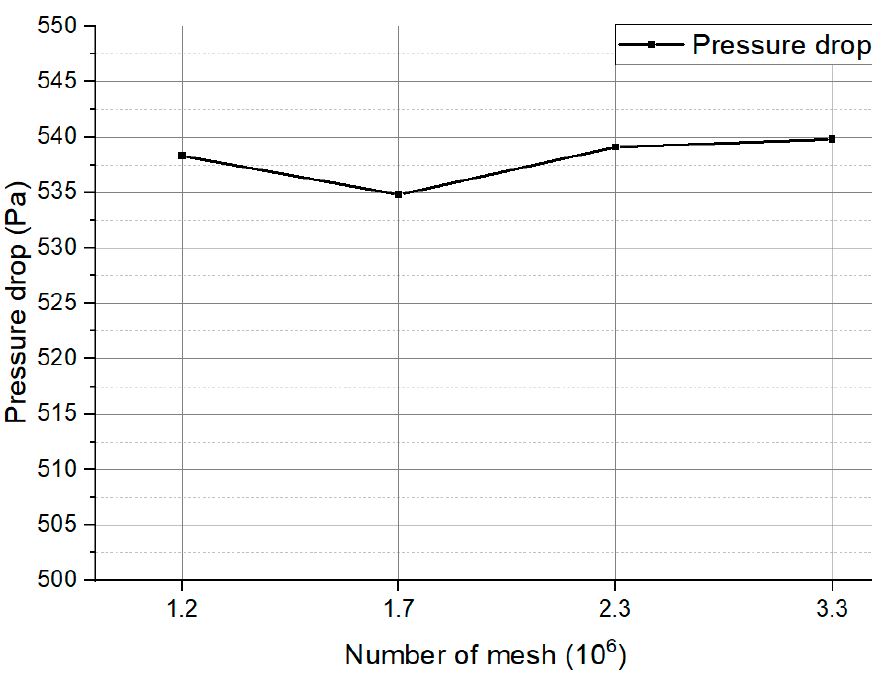
Figure 2. Pressure drop with the number of grids.